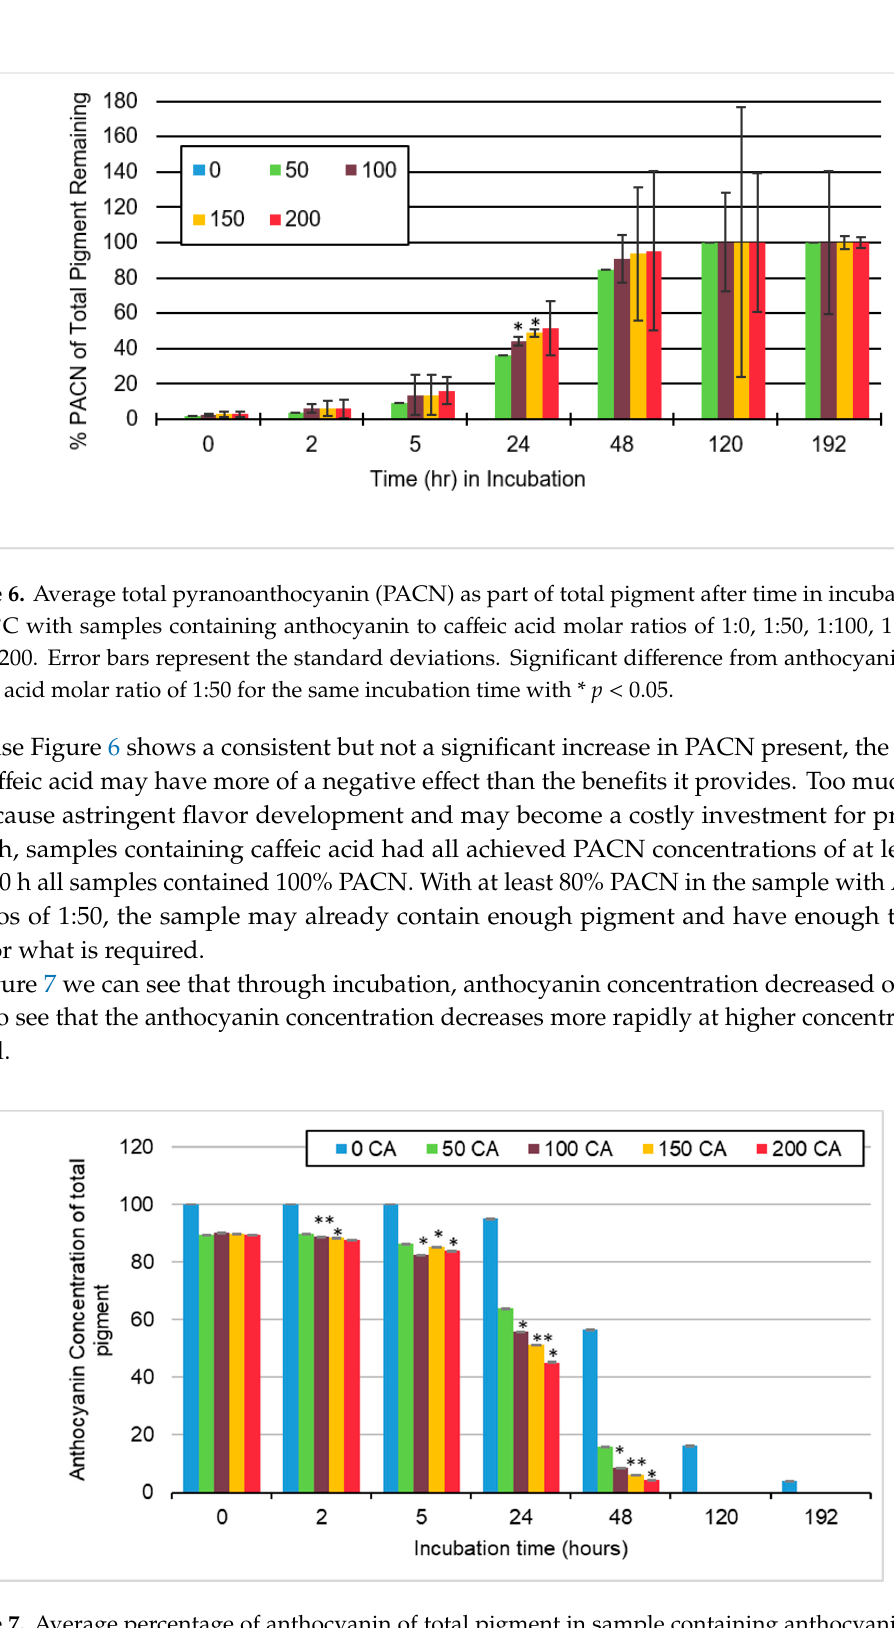
Figure 7. Average percentage of anthocyanin of total pigment in sample containing anthocyanin to caffeic acid molar ratios of 1:0, 1:50, 1:100, 1:150, and 1:200 after hours of incubation at 65 °C. Error bars represent the standard deviations. Significant difference from ACN:CA molar ratio of 1:50 for the same incubation time with * p < 0.05, ** p < 0.01.